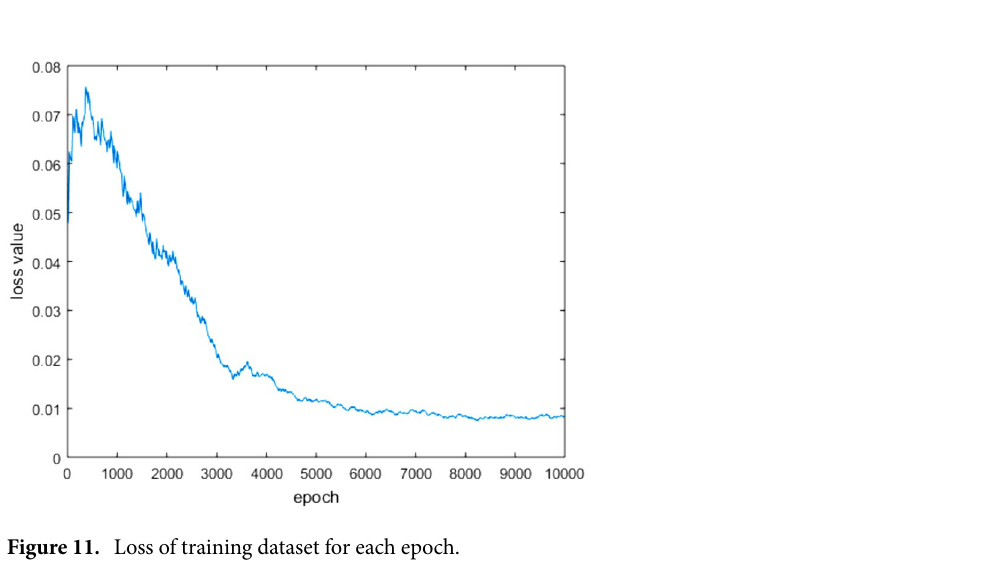
Figure 11. Loss of training dataset for each